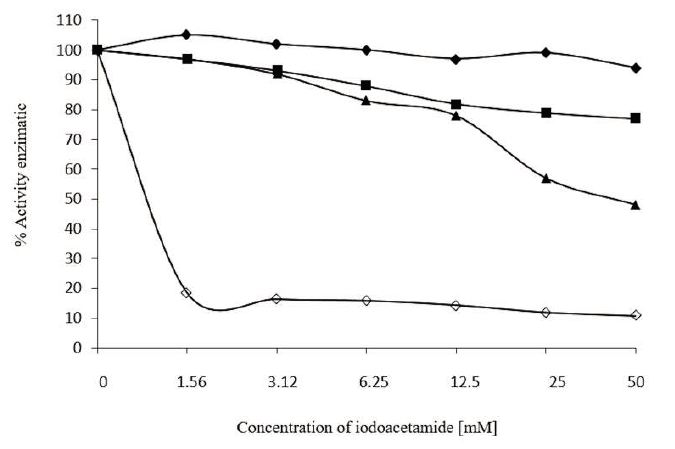
Figure 11. Effect of iodoacetamide on enzymatic activity of β -glucosidase in S. edule. Different concentrations and incubation times ♦─♦ 30 min, ■─■ 24 h, ▲─▲ 72 h, and ◊─◊ β -glucosidase. 1 M incubated previously in urea for 30 min. Enzymatic activity